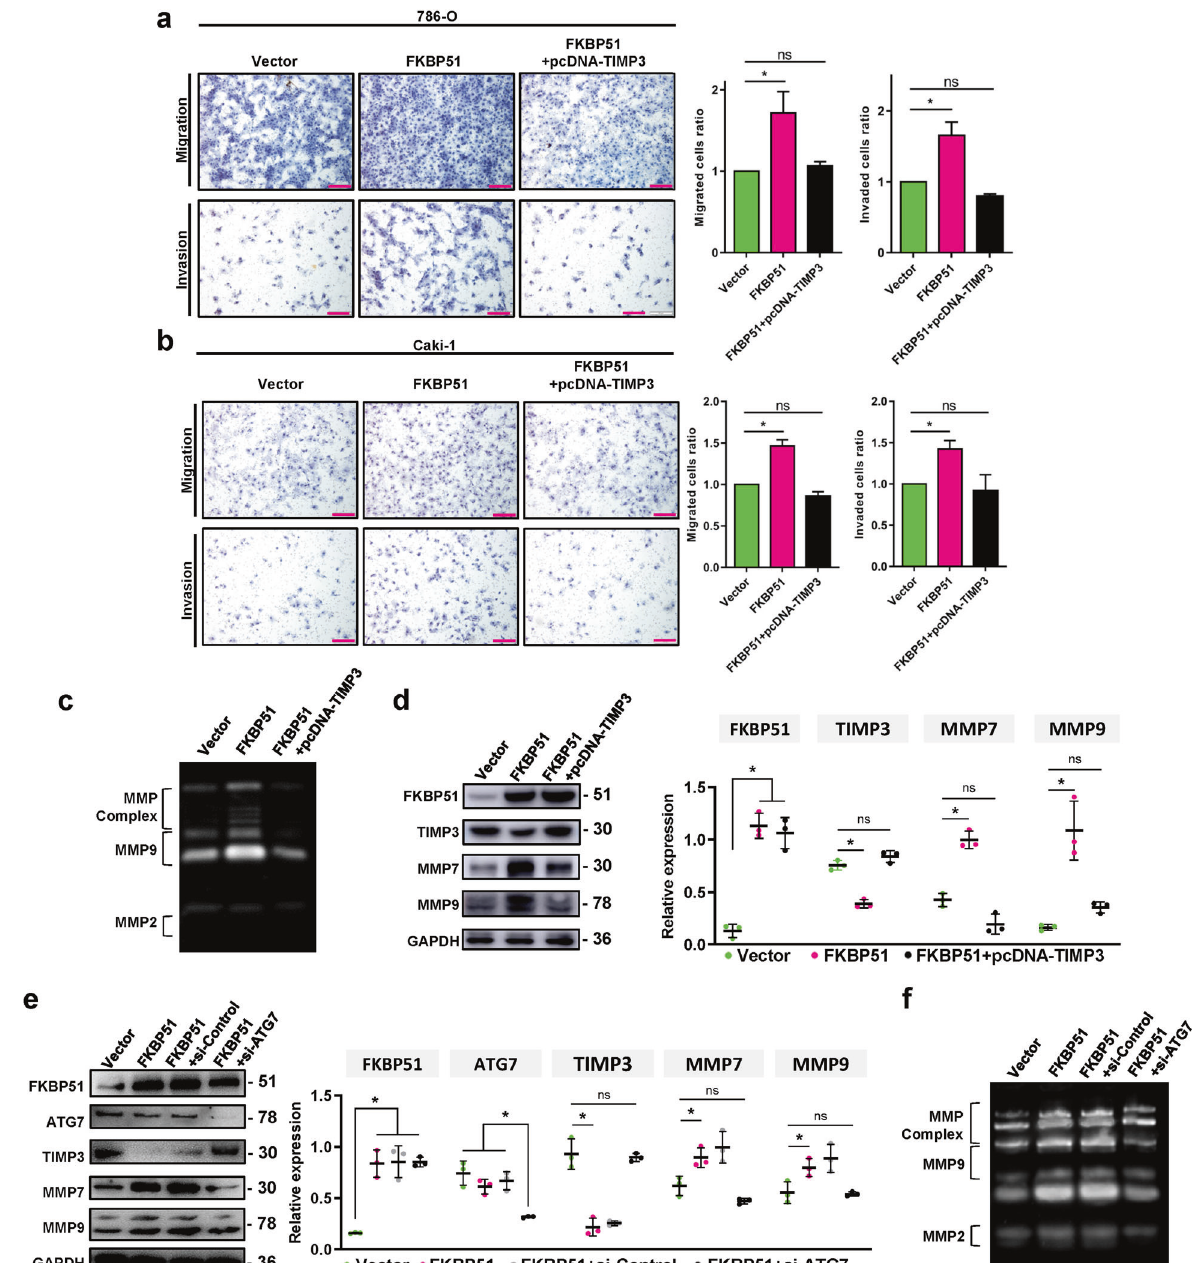
Fig. 7 TIMP3 autophagic degradation is required for FKBP51-induced invasion and migration. a , b Transwell assays were conducted to analyze the migratory and invasive abilities of FKBP51-overexpressing 786-O and Caki-1 cells transfected with or without pcDNA3.1-TIMP3. c The degradation activity of MMP2, MMP9 and MMPs complex was detected by gelatin zymography in FKBP51 overexpressing 786-O cells transfected with or without pcDNA3.1-TIMP3. d Western blotting was used to detect the expression levels of TIMP3, MMP7 and MMP9 in FKBP51 overexpressing 786-O cells transfected with or without pcDNA3.1-TIMP3. Schematic representation of quantitative data of the indicated proteins. Representative images from three independent experiments are shown. e Western blotting was used to detect the expression levels of FKBP51, ATG7, TIMP3, MMP7, and MMP9 in FKBP51 overexpressing 786-O cells transfected with siRNA-Control (si-Control) or siRNA-ATG7 (si-ATG7). f The degradation activity of MMP2, MMP9, and MMPs complex was detected by gelatin zymography in FKBP51 overexpressing 786-O cells transfected with siRNA-Control (si-Control) or siRNA-ATG7 (si-ATG7). * p <